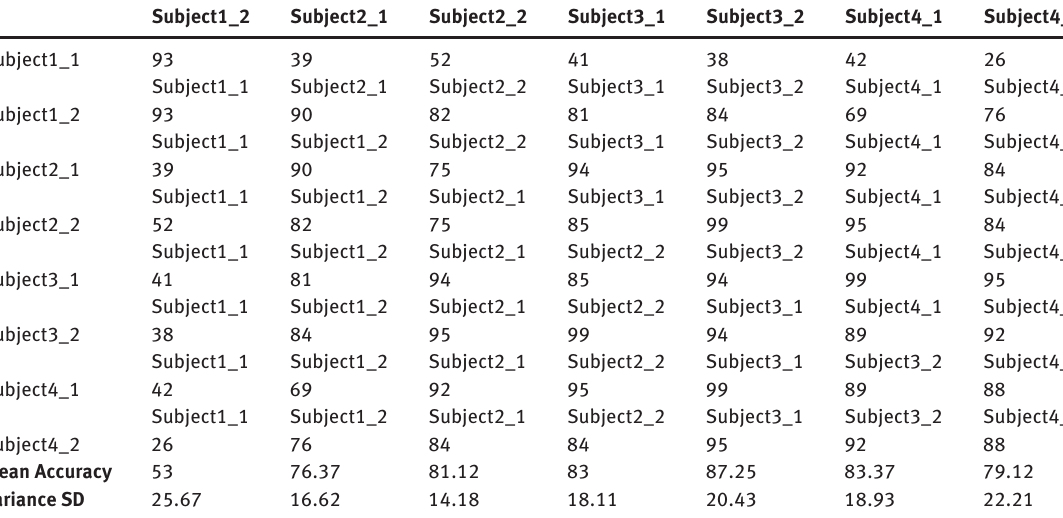
Table 2: Accuracy results, mean accuracy, and variation on